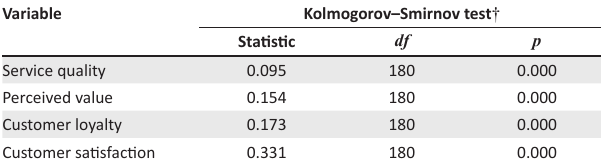
TABLE 3: Results of tests of normality.